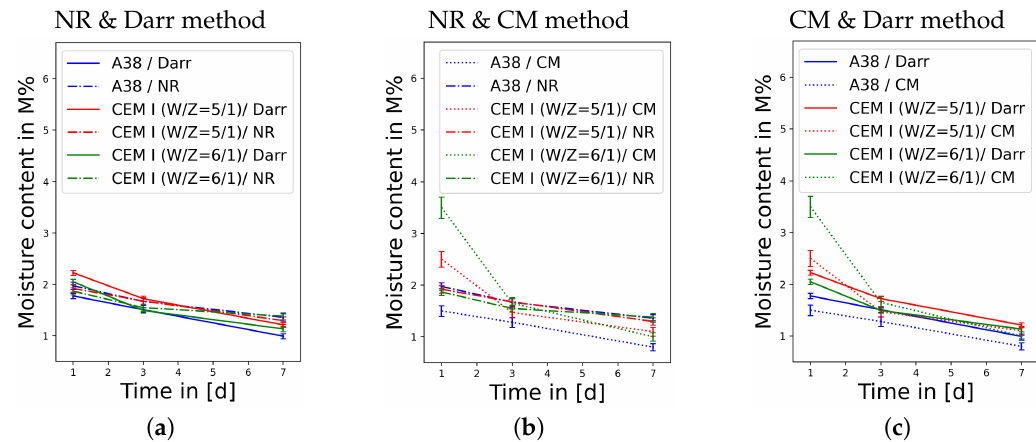
Figure 5. A pairwise comparison of the different methods showing the decrease of moisture content over time; the samples are illustrated in different colours, where the CEM I (G/Z = 5/1) sample is orange, the CEM I (G/Z = 6/1) sample is green and the A38 sample is blue: ( a ) Comparison of NR with the Darr method. ( b ) Distinction between NR and the CM method. ( c ) Comparison of the CM method with the Darr method.